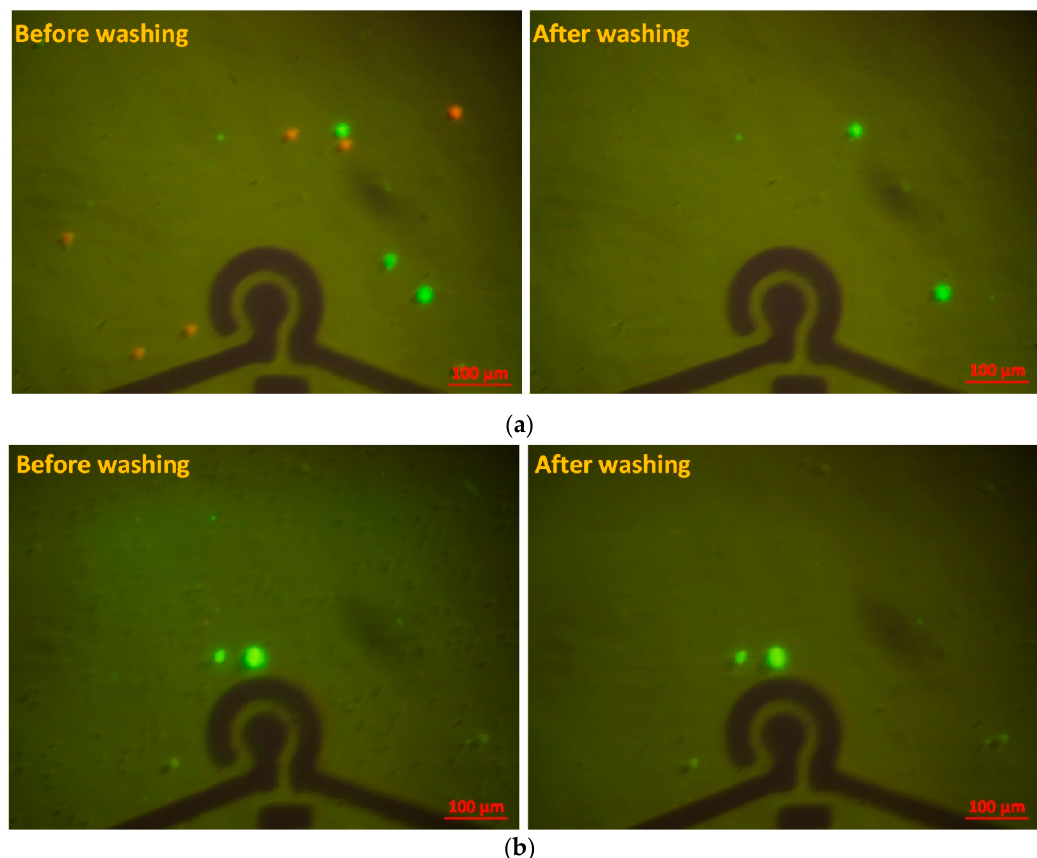
Figure 6. Fluorescence microscopic images of the mixture of cell samples around the aptamer-modified electrodes with the SAM of AuNPs area before and after the final washing step: ( a ) A549 cells (green) with the concentration of 5 × 10 2 cells/ µ L, and HeLa cells (red) with the concentration of 10 3 cells/ µ L; (b) A549 cells (green) at the concentration of 5 × 10 2 cells/ µ L in 5% whole blood sample.